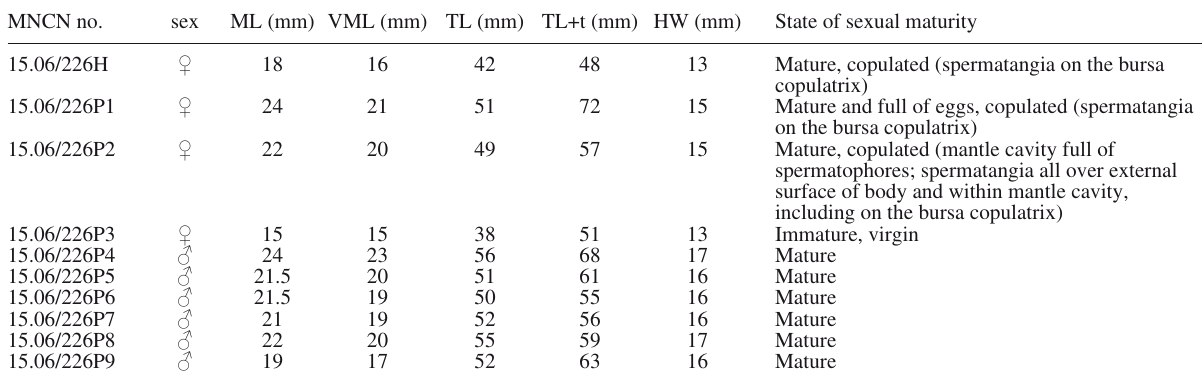
Table 1. – Specimens of the type series; MNCN 15.06/226H is the holotype, all the others are paratypes. ML, dorsal mantle length; VML, ventral mantle length; TL, total length (less the tentacles); TL+t, total length with the tentacles; HW, head width. MNCN